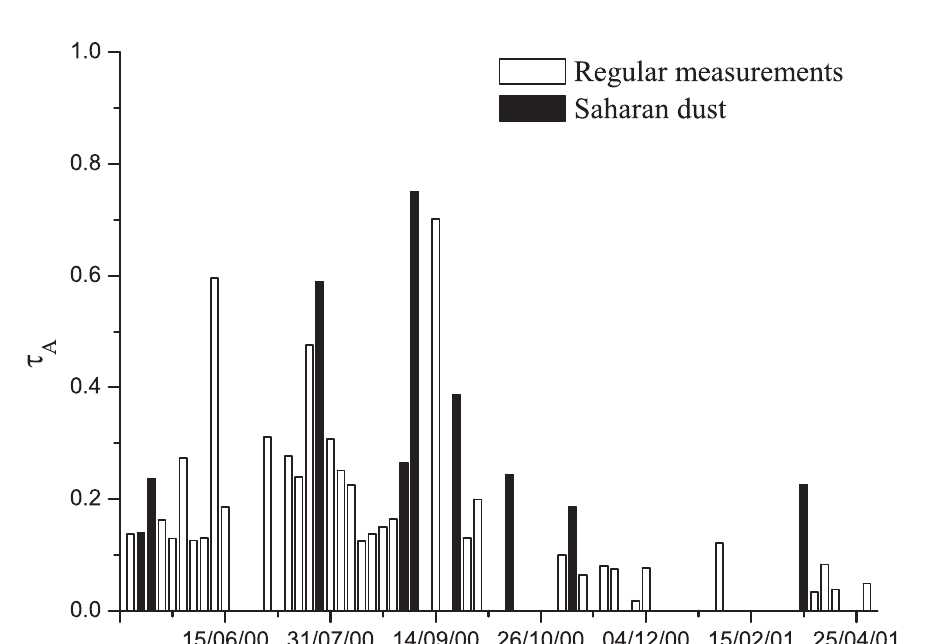
Fig. 8. Integrated aerosol extinction at 355 nm for all night time lidar measurements in Tito Scalo in the period May 2000-April 2001. Regular measurements are reported in white, Saharan dust measurements are reported in black.